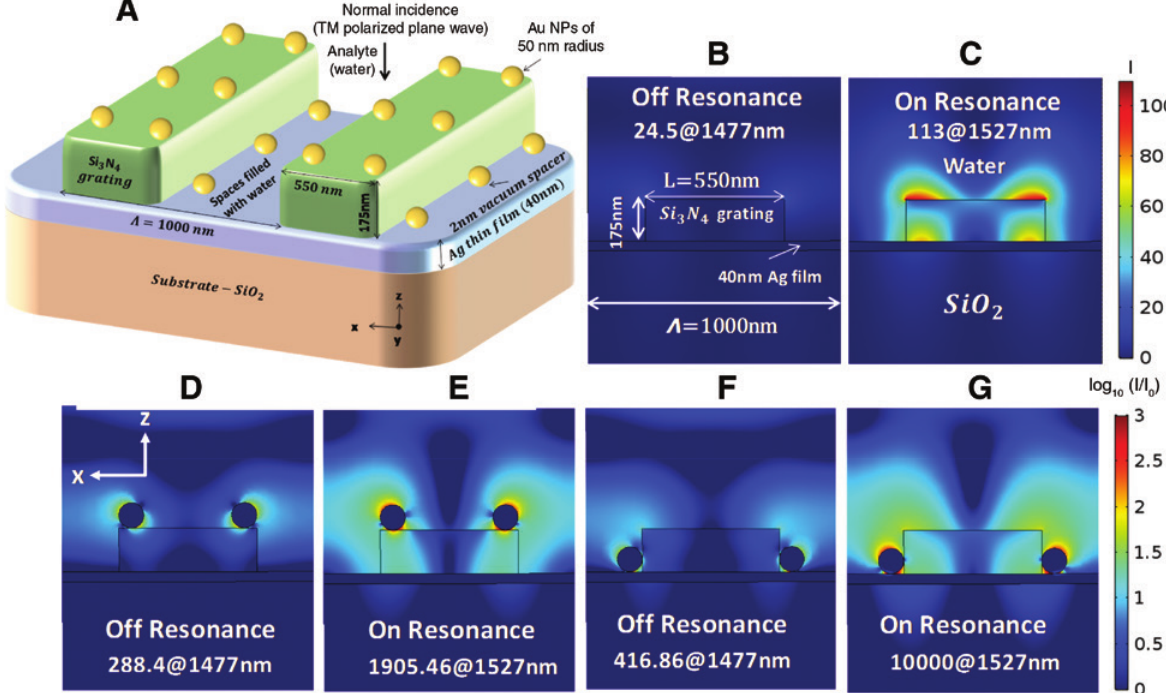
Figure 22: Ultrahigh field enhancement under ESP-LSP coupling in thin dielectric grating and thin metal film geometry. (A) Thin dielectric grating on thin metal film scheme. (B–C) Field distributions calculated at and off resonance wavelength without NPs. (D–G) Field distributions calculated with NPs on the top and bottom corners at and off resonance